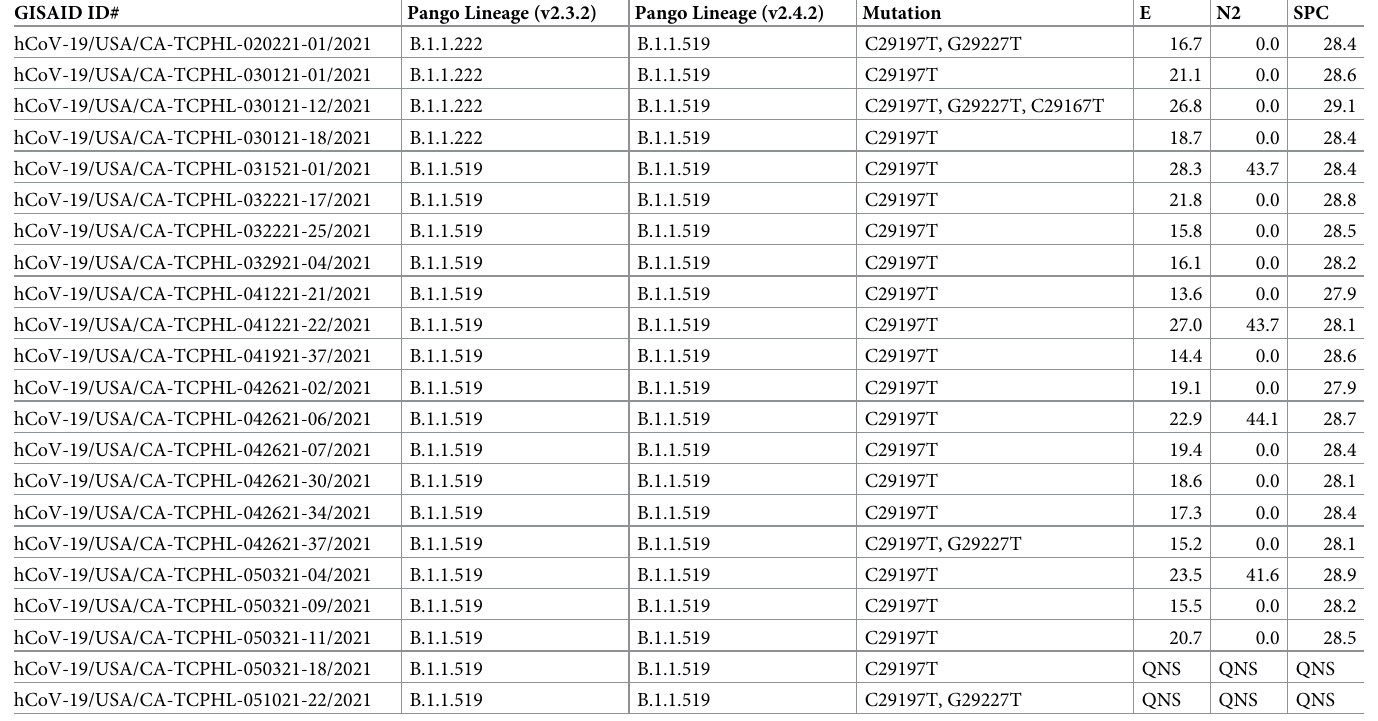
Table 1. Clinical Samples showing C29197T mutation and NGTF. GISAID